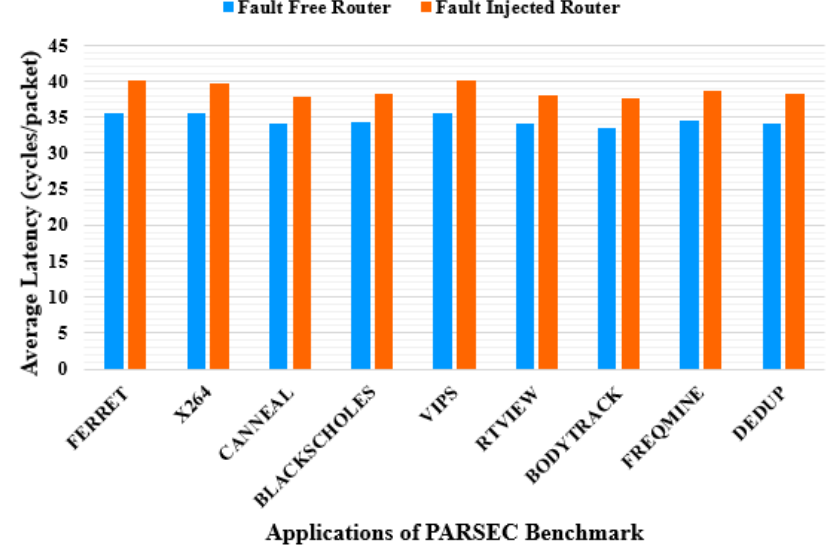
Figure 14. Latency comparison under PARSEC benchmark traffic